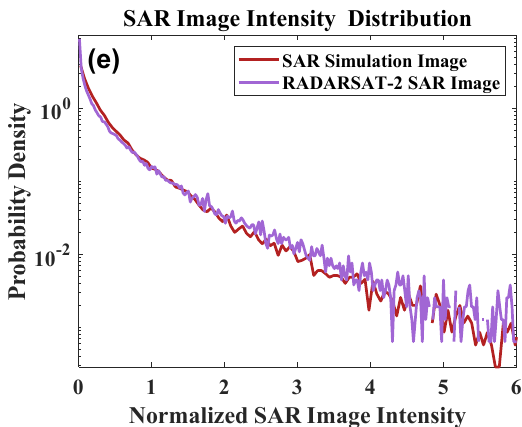
Figure 3. The comparison between the simulated and the actual SAR images. ( a ) The simulated HH-polarized SAR NRCS image; ( b ) the actual HH-polarized SAR NRCS images; ( c ) the image spectrum of the simulated SAR image; ( d ) the image spectrum of the actual SAR image; ( e ) the statistical probability density distribution of SAR image intensity.